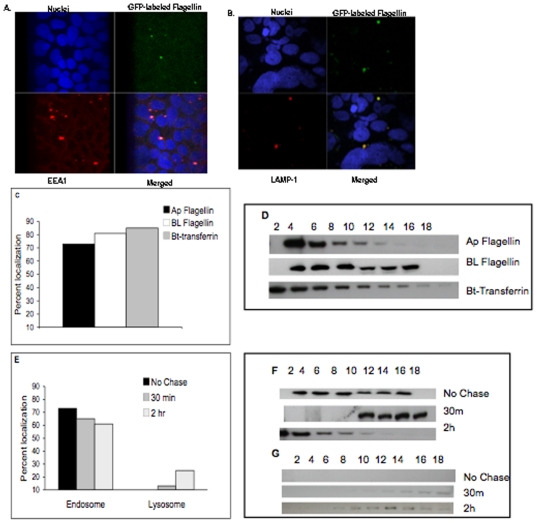
Flagellin co-localizes with endosomal and lysosomal markers.
A. Following AP exposure to Caco-2BBe cells, GFP-labeled flagellin (green) was internalized and, within 15 min, co-localized with an antibody that recognized an early endosomal surface marker (EEA1) and secondary antibody (red) as shown in the middle z-sections by confocal microscopy. Lower right panel shows merged images and indicates co-localization of flagellin with EEA1.Cell nuclei were stained with DAPI (blue). B. Within 1 h flagellin (green) co-localized with the lysosome marker LAMP-1 (red). The confocal images shown are representative of 3 independent experiments. C–F. 6HIS-Flagellin was added to the AP or BL side of polarized Caco-2BBE cells at 19°C allowing traffic up to (but not beyond) the recycling endosome. In some experiments biotinylated transferrin also was added to the apical surface as a marker for the endosomal pathway. Cells then were either fractionated (see methods) without allowing further traffic or warmed to 37°C for the times indicated prior to fractionation. NOTE: White arrows indicate flagellin protein in A and B. C. Intracellular localization of internalized flagellin protein (normalized for total cell-associated protein) following incubation at 19°C. D. Western blots of endosomal fractionation as described in C and in the methods. E. Intracellular localization of 6HIS-Flagellin when internalization of protein at 19°C was followed by incubation at 37°C allowing traffic beyond the recycling endosome. F-G. Western blots of fractionation as described in E and in the methods.